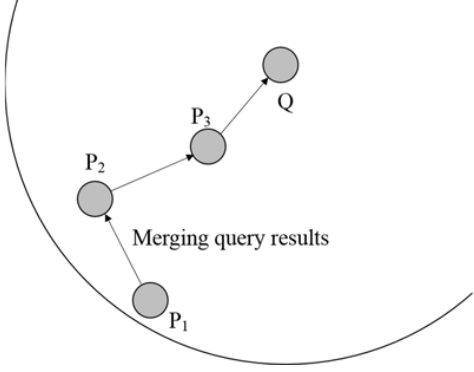
Figure 7. Merging results from P 1 to Q